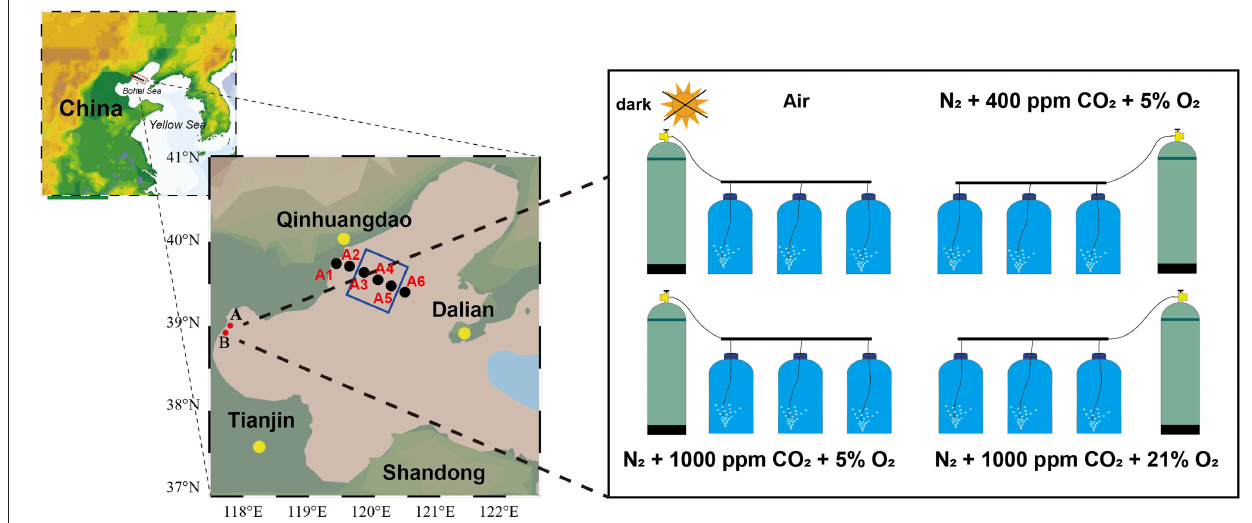
FIGURE 1 | Location of the study area and incubation setup. Black dots indicate sampling sites during Bohai Sea cruises, red dots indicate hatchery experiment sampling sites, and the blue square indicates the hypoxia zone [defined as dissolved oxygen (DO) < 3mg L − 1 by Zhai et al., 2012].